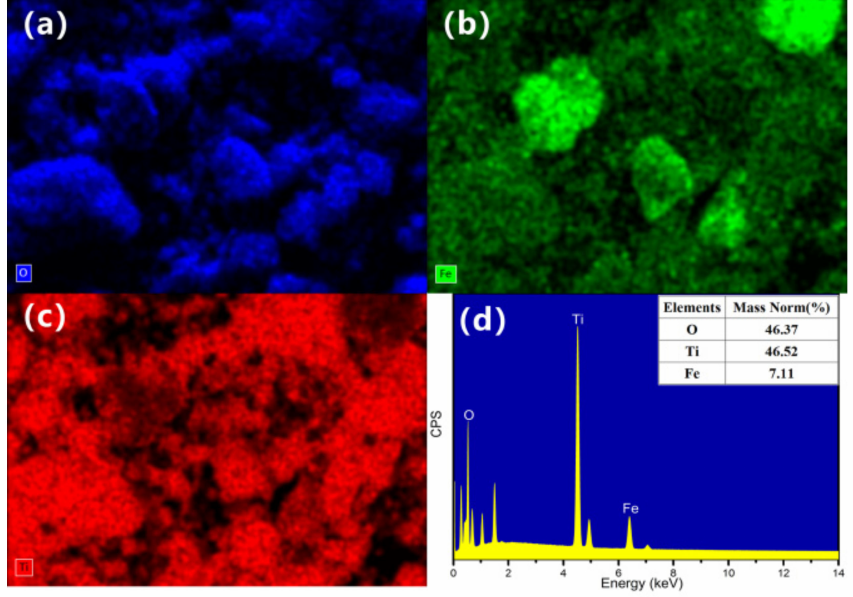
Figure 4. FESEM elemental mapping and EDS patterns of Fe 3 O 4 @TiO 2 . ( a ) oxygen elements; ( b ) Fe elements; ( c ) Ti elemnts; ( d ) EDS patterns of Fe 3 O 4 @TiO 2